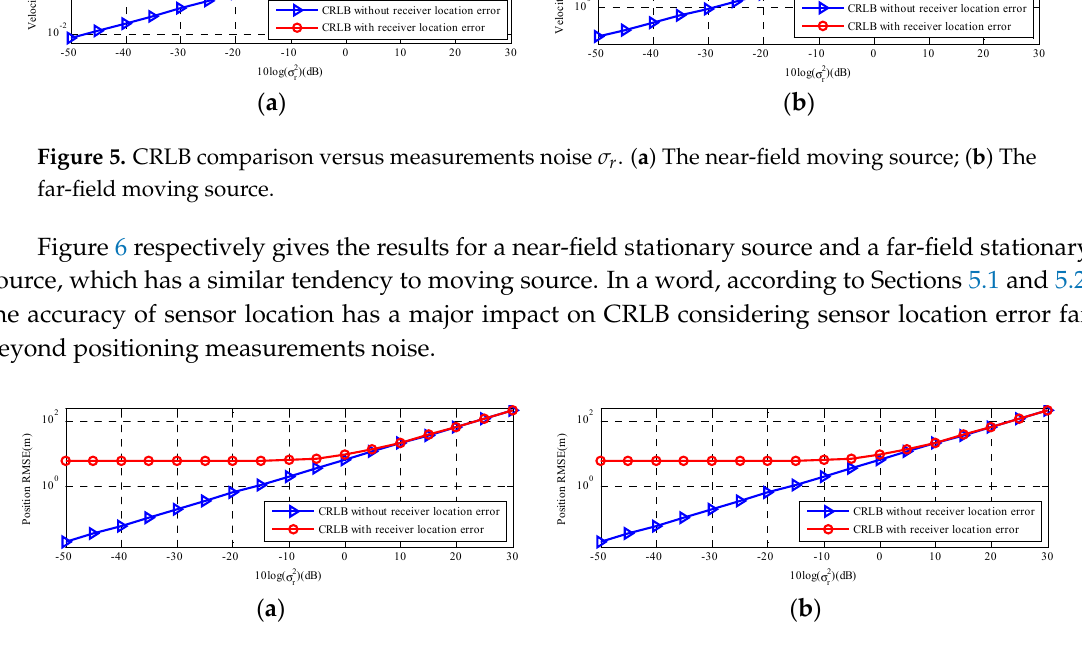
Figure 6. CRLB comparison versus measurements noise σ r . ( a ) The near-field stationary source; ( b )